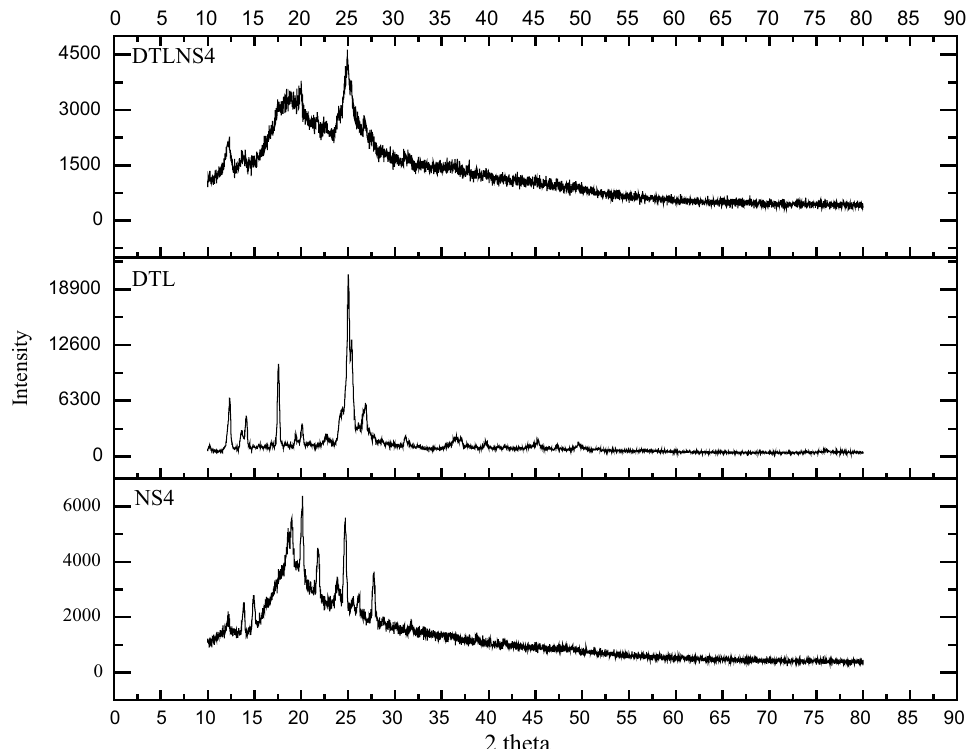
Fig. 7 PXRD diffraction analysis of DTL (dithranol), NS4 (nanosponges formulation) and DTLNS4 (dithranol